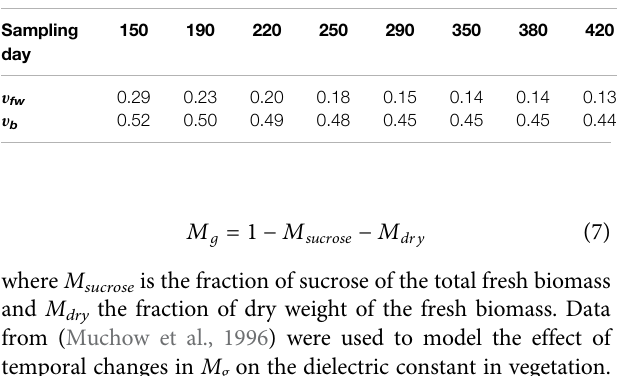
TABLE 1 | Free and bound water fractions after several moments in the growing season. υ b and υ fw computed with fi eld experiment results Muchow et al.